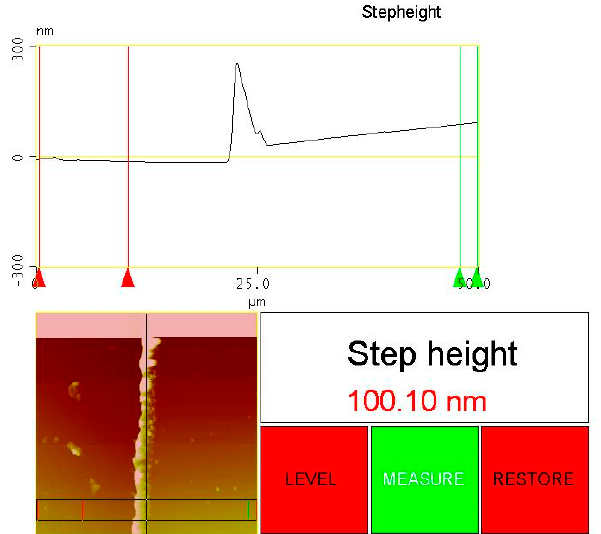
Figure 1. Thickness measurements of CoSiB thin film (100 nm) on glass substrate using